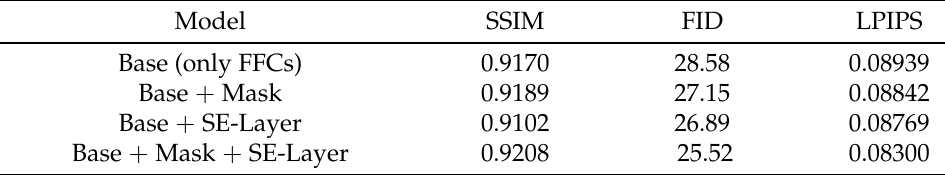
Table 6. Results of experiments on input with a resolution of 512 × 512.